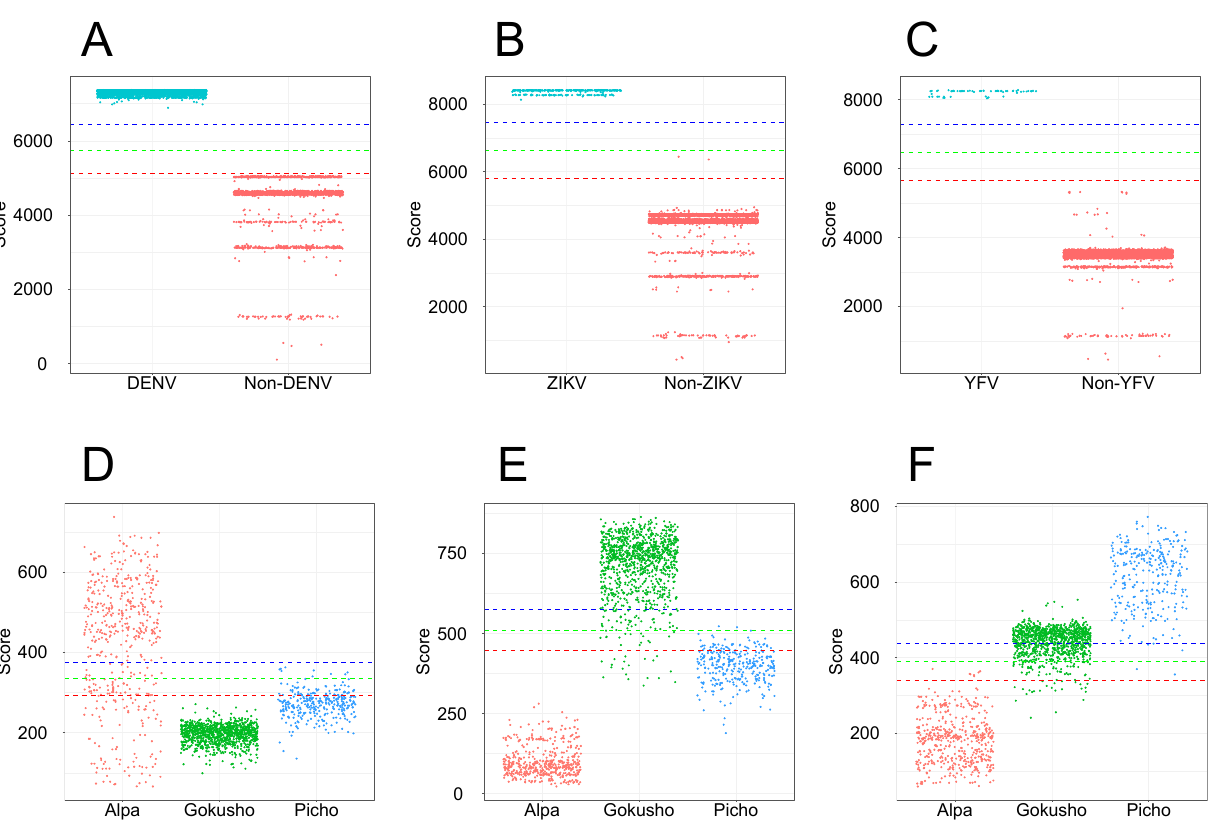
Figure 1. Full-length protein sequences as a source for the construction of discriminative profile HMMs. Profile HMMs of DENV ( A ), ZIKV ( B ) and YFV ( C ) were constructed and tested by similarity searches using a training set composed of specific polyprotein sequences and tested with hmmsearch program against a bona fide dataset of 6364 Flavivirus sequences comprising a wide variety of viral species. For Microviridae , profile HMMs were constructed using sequences of the major capsid protein (VP1) specific to Alpavirinae ( D ), Gokushovirinae ( E ), and Pichovirinae ( F ) subfamilies and the models were validated against a bona fide dataset of 1866 VP1 sequences of Microviridae , comprising members of three subfamilies. Each column scatter plot depicts the results obtained for the tested species/subfamily the remaining viruses of the group, according to the respective alignment scores. The dots correspond to scores obtained by each profile HMM against the different protein sequences of the tested datasets. Dashed horizontal lines indicate cutoff scores corresponding to 70% (red), 80% (green), and 90% (blue) of the alignment score observed for the lowest hit of the training